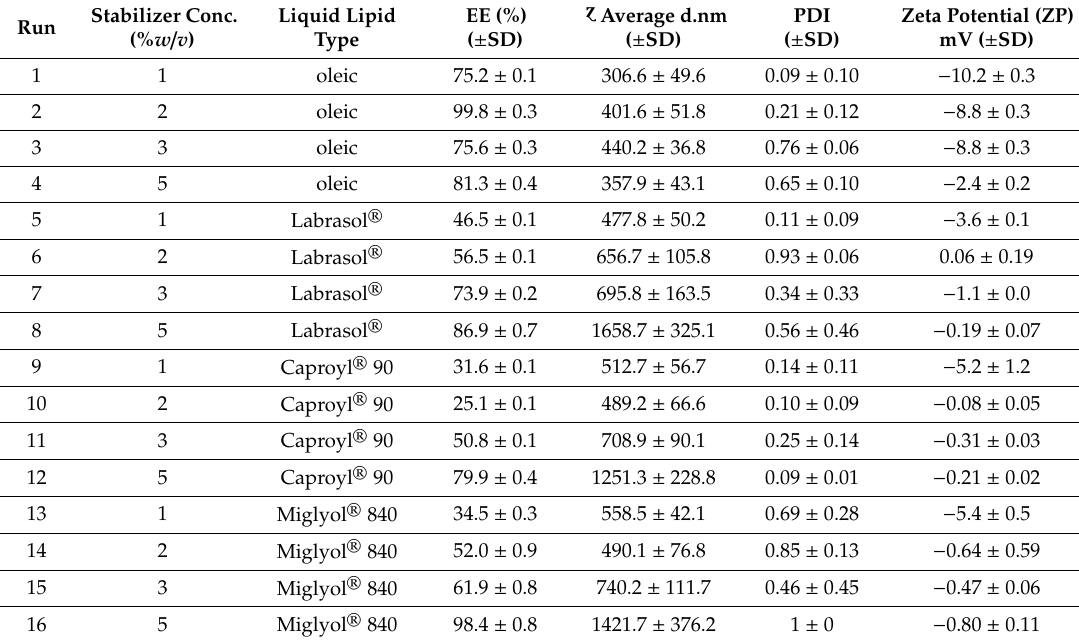
Table 2. Experimental runs and their observed responses.